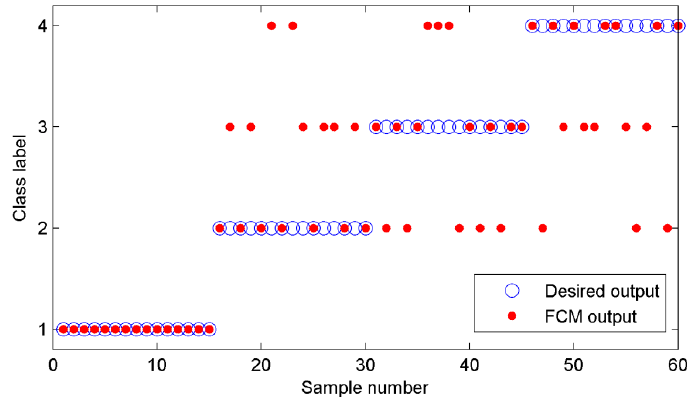
Figure 9. The classification results of FCM clustering without LFS method.